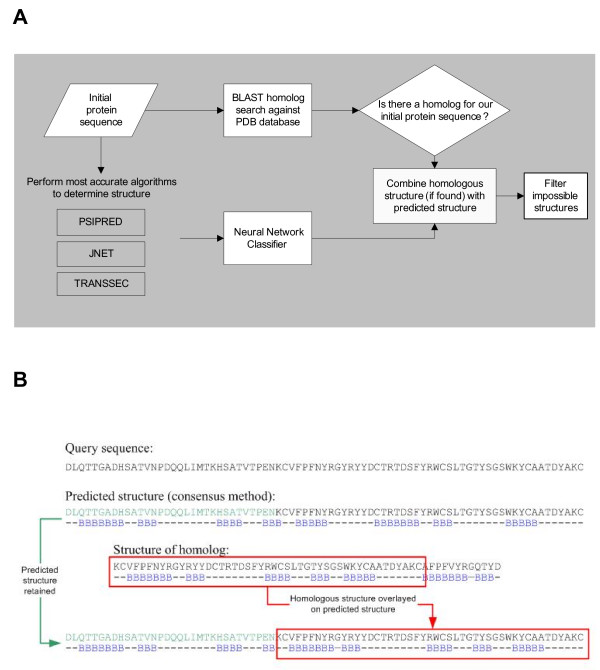
A) Flow chart outlining how protein sequences are processed by PROTEUS. Each query sequence is simultaneously processed through PROTEUS' three de novo predictors (lower left corner) and through a BLAST comparison and global alignment (via XALIGN) against the PDB, to yield a 3D-to-2D mapping. The two secondary structure predictions are merged and filtered to produce a final consensus prediction. B) Detail illustrating how the two predictions are merged in the final processing step.